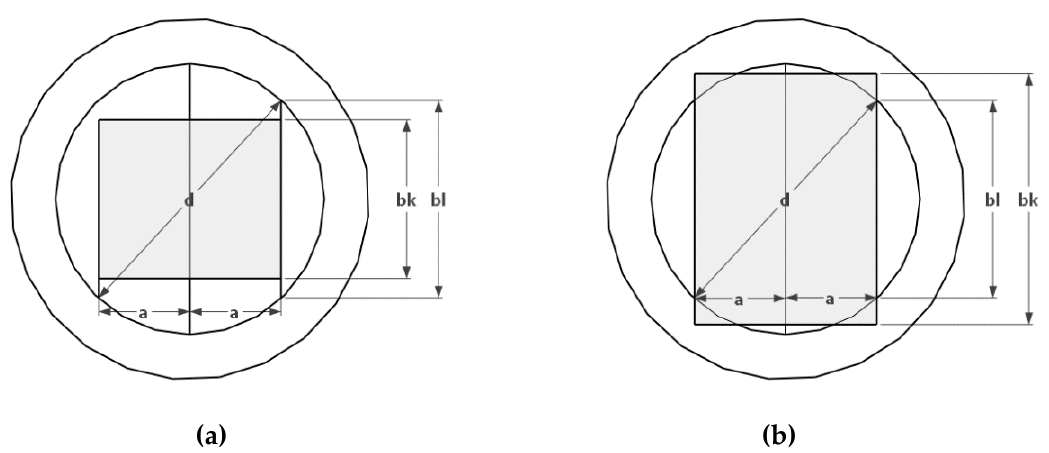
Figure 9. Check of the condition b k < b l . ( a ) Timber is the same as the log length. ( b ) Timber is shorter than the log length.